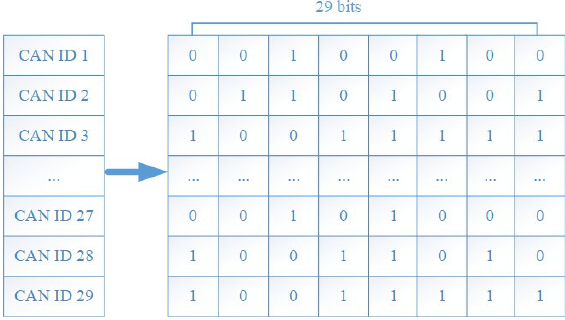
Figure 3. Sequential arrangement of the CAN data.